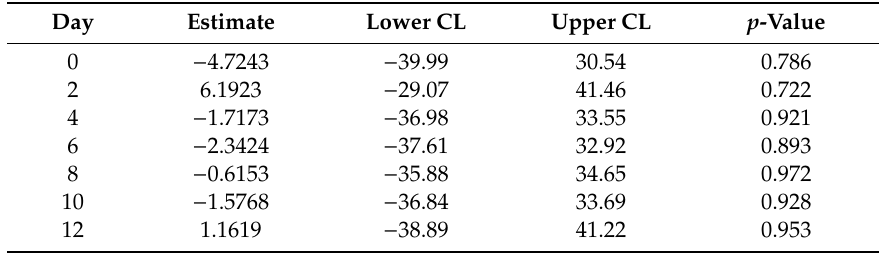
Table 5. Di ff erence between 0-dose and low-dose groups in least square means of OCT4 RNA expression according to day.